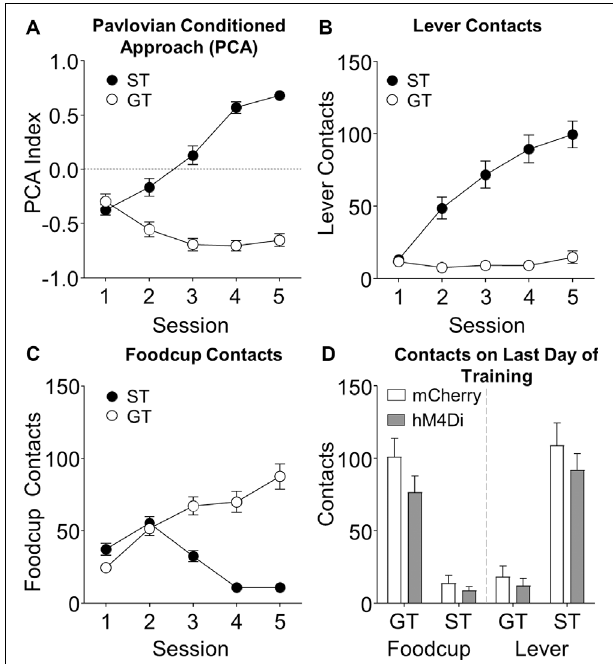
FIGURE 1 | Pavlovian lever autoshaping (PLA) acquisition data. Data represents (A) average Pavlovian Conditioned Approach (PCA) score, (B) lever contacts, (C) foodcup contacts during training; and (D) both lever and foodcup contacts on fifth training session are represented as a function of viral condition; there were no differences as a function of virus ( p s > 0.05).